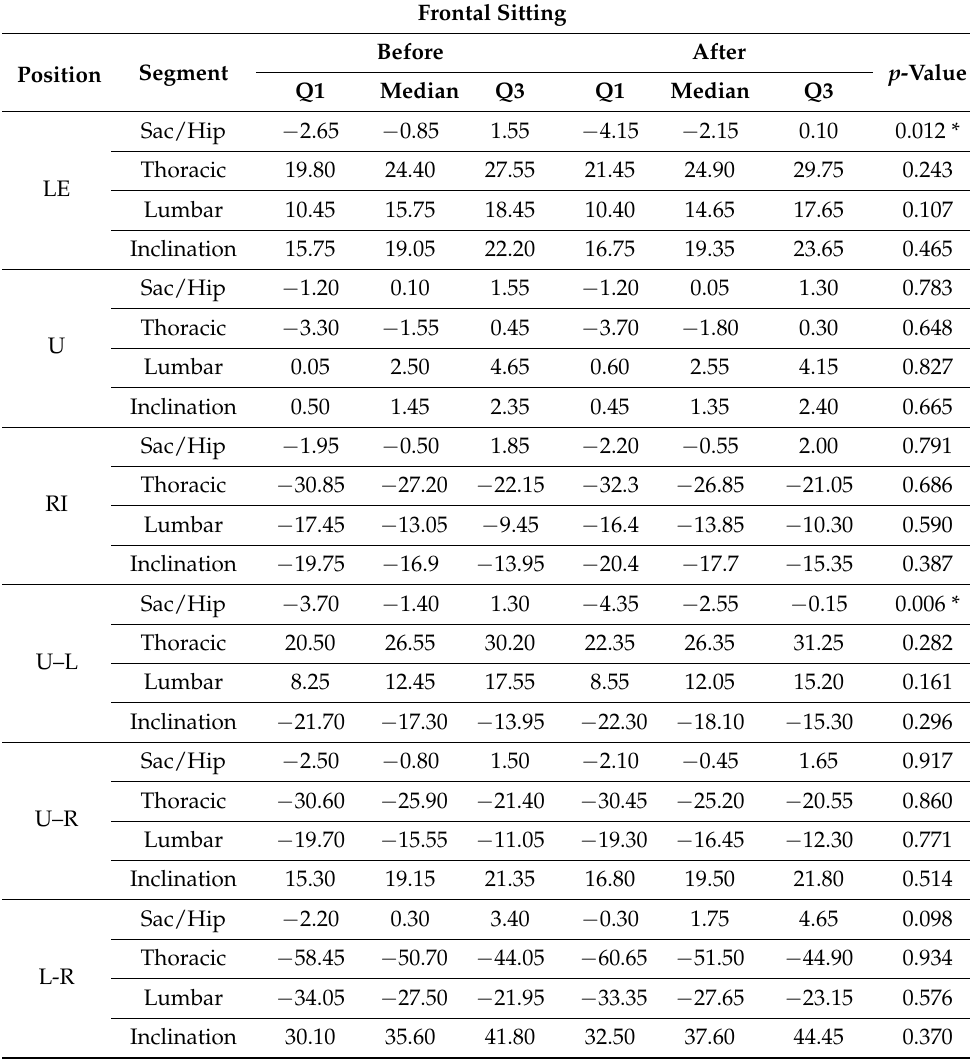
Table 4. Medians and interquartile ranges of total inclination and lumbar, thoracic and sacrum/hip inclinations in degrees measured before and after the intervention in sitting position in the frontal plane: left lateral-flexion (LE), upright (U), right lateral-flexion (RI) and estimated ROM from upright to flexion (U–F), upright to the left (U–E), upright to the right (U–R) and left to the right lateral-flexion (L–R) ( n = 76). Frontal